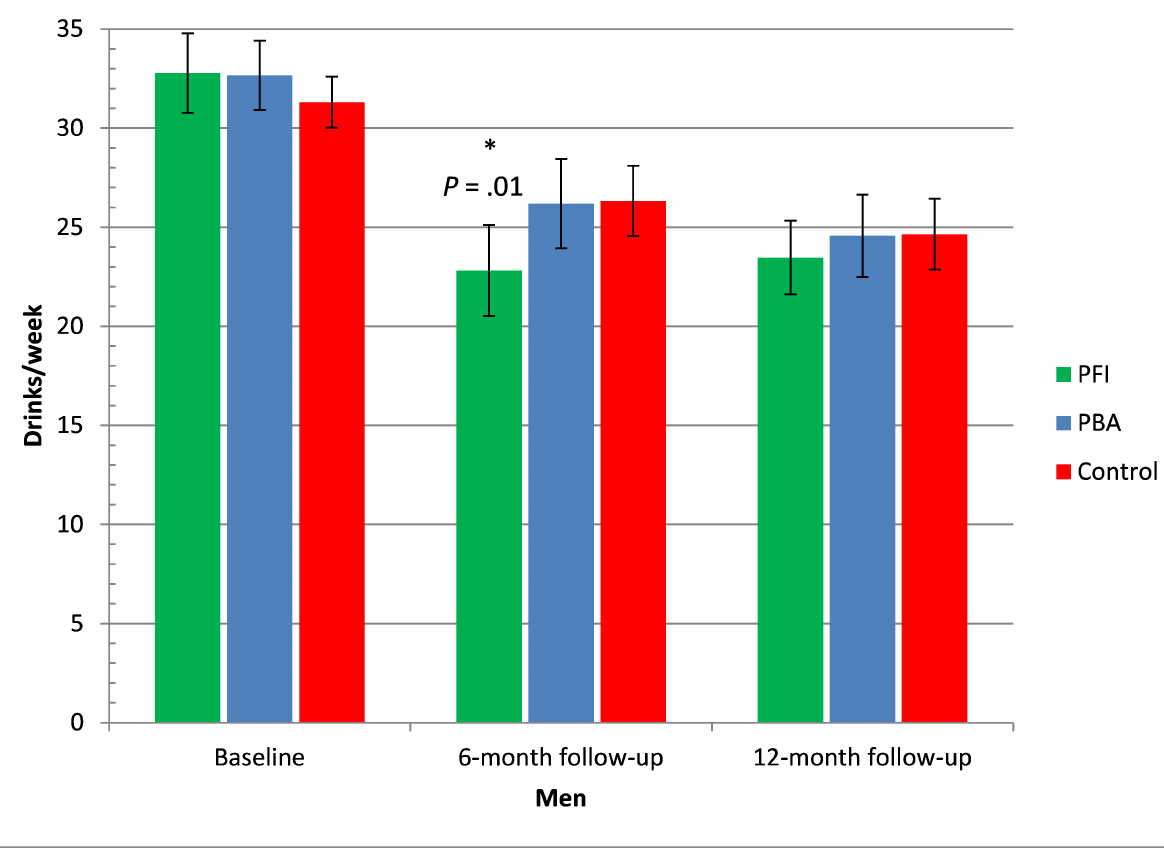
Figure 8. Alcohol consumption at baseline and at 6- and 12-month follow-ups for men based on completers-only analysis. n = 481 after 6 months and 598 after 12 months. Error bars indicate 95% confidence interval. Drinks/week = mean number of standard drinks in a typical week, PBA = Internet-based personalized brief advice intervention, PFI = Internet-based brief personalized feedback intervention. * P value for difference between PFI and control group (Kruskal-Wallis